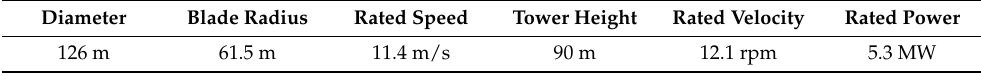
Table 2. Overview of the NREL 5 MW reference